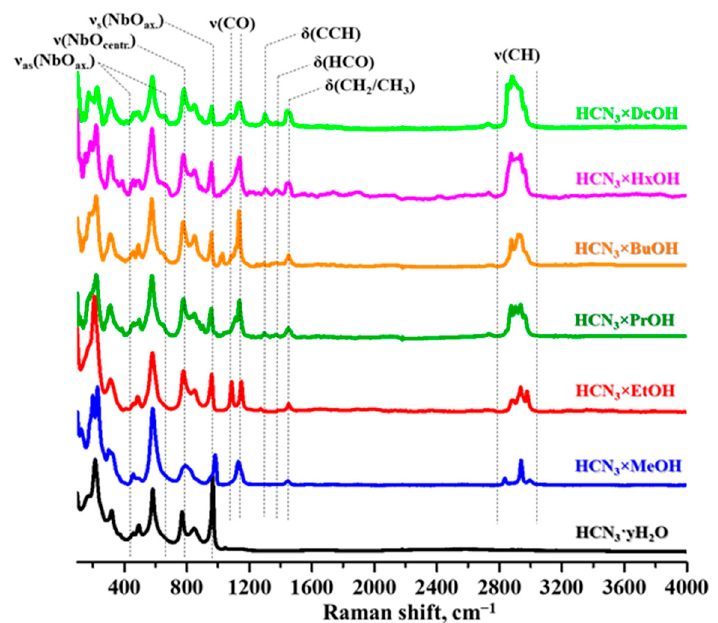
Figure 3. Raman spectra of the protonated niobate and its n -alkoxy derivatives.